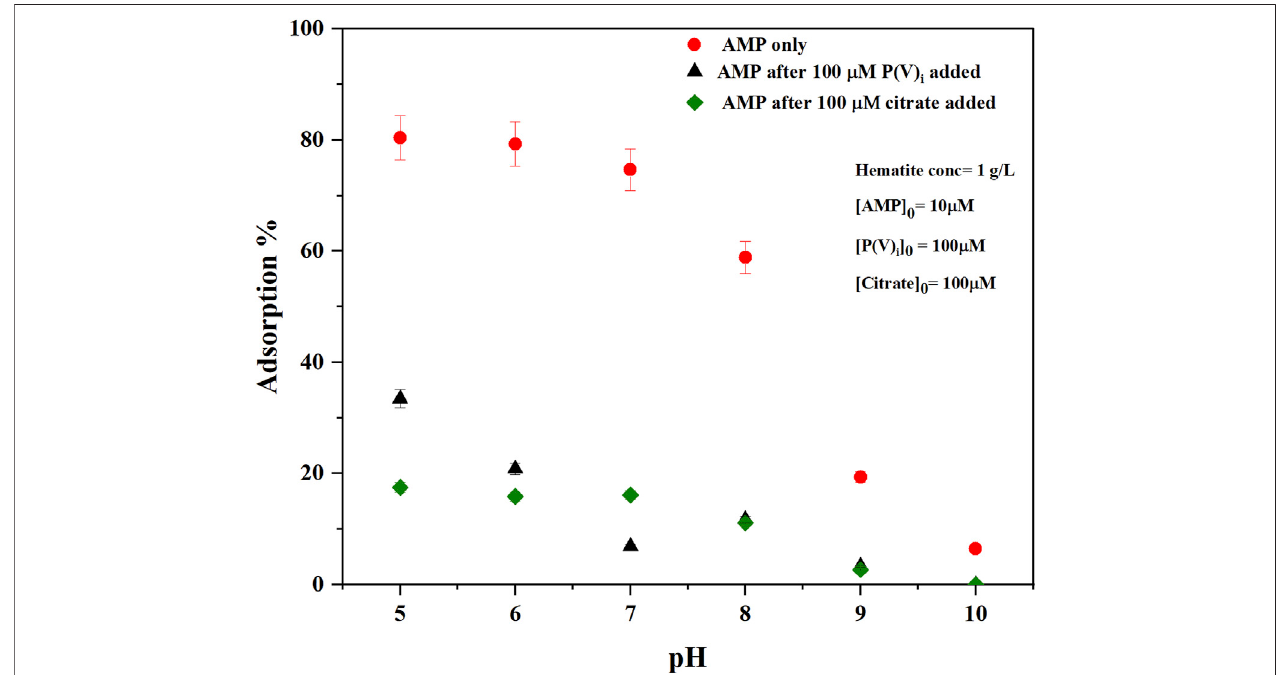
FIGURE3 | Macroscopic adsorption% ofAMP on hematite as afunction of pH at ionic strength (I =0.01 M NaCl) without any other adsorbates (AMP only) or with competitive adsorption of either inorganic phosphate (P(V) i ) (AMP after 100 μ M P(V) i added) or citrate (AMP after 100 µM citrate added) [AMP] 0 [Phosphate] 0 , and [Citrate] 0 represent initial concentrations of added adsorbate in the reaction mixture. Error bars represent standard deviation of three